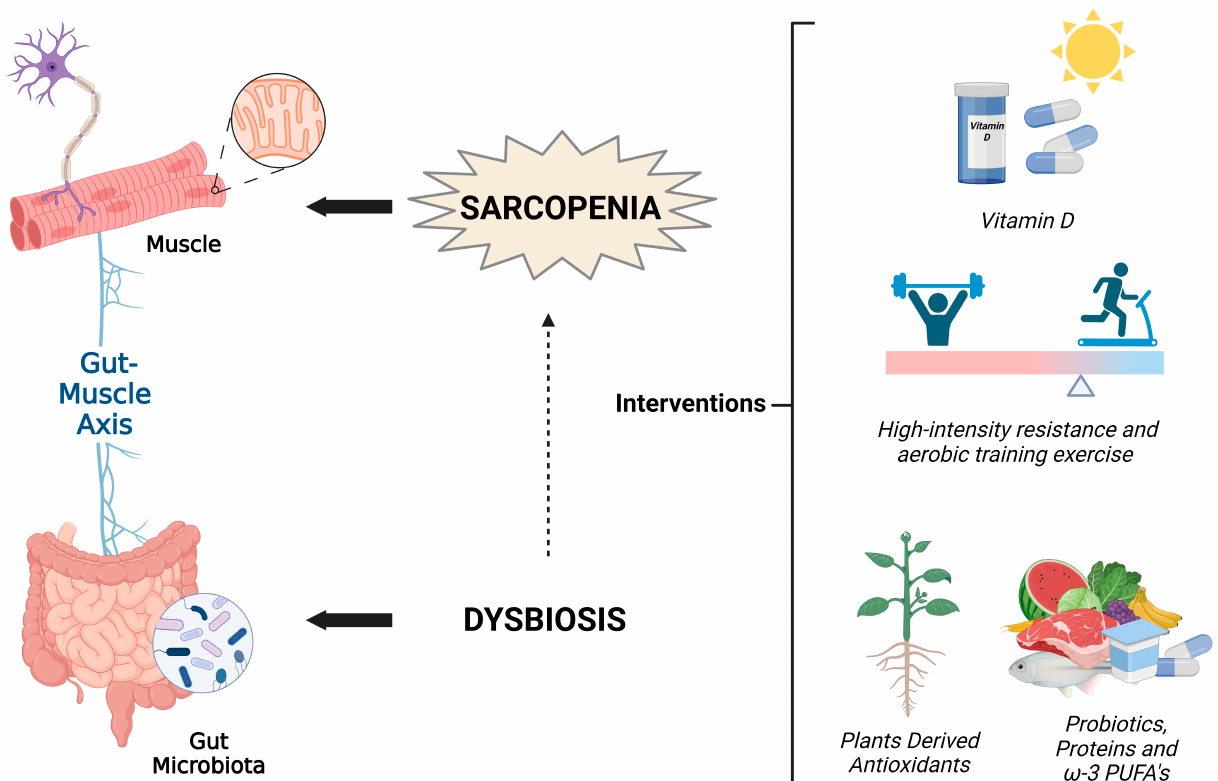
Figure 1. A comprehensive approach to an integrated intervention to preserve musculoskeletal health in aging.